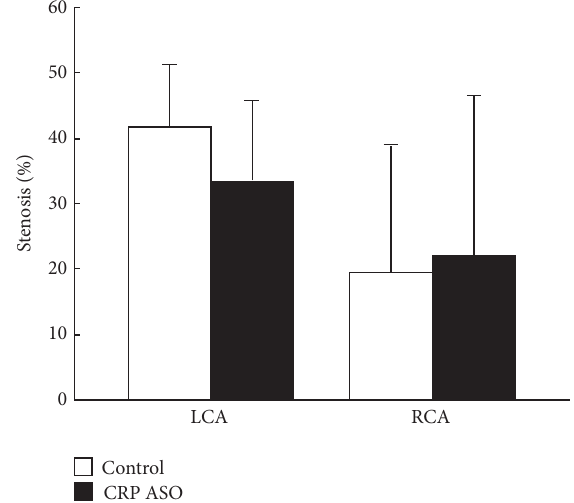
Figure 10: Analysis of coronary atherosclerosis. The heart was cut into 7 blocks, and blocks I and II containing left and right coronary trunks were sectioned in 500 𝜇 m intervals (3 sections from each block) and stained with EVG. Coronary stenosis (lesion area/total lumen area × 100(%) was measured and is expressed as percentage. LCA indicates left coronary artery trunks; and RCA, right coronary artery